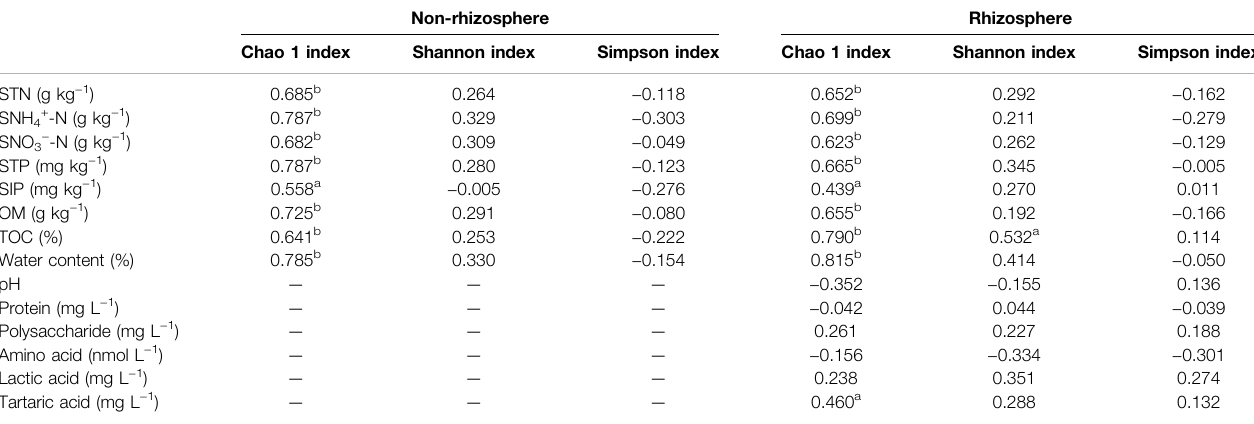
TABLE 2 | Spearman ’ s correlation coef fi cients between microbial diversity indices, sediment properties and root exudates.